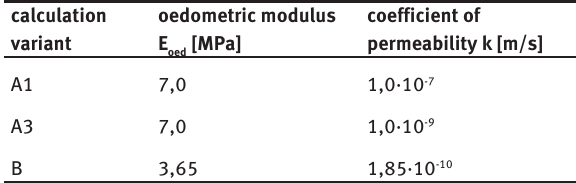
Table 1: Consolidation parameters of the organic soil. calculation